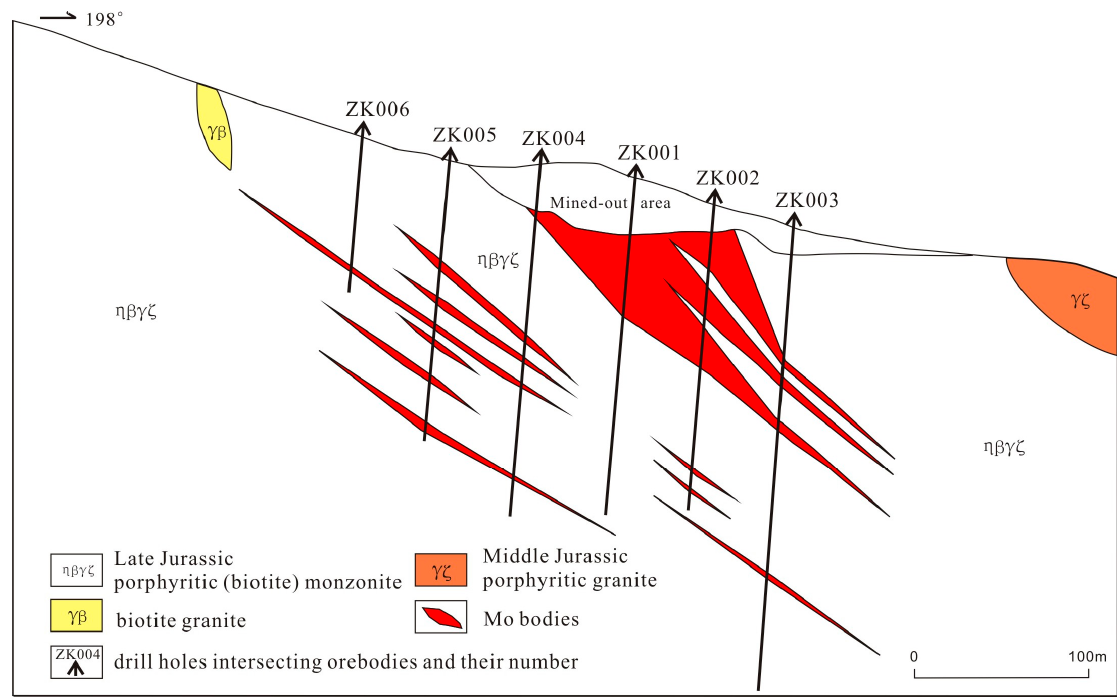
Figure 5. Geological cross-section of Line No. 0 through the Fu’anbu Mo ore deposit (modified after [11]).